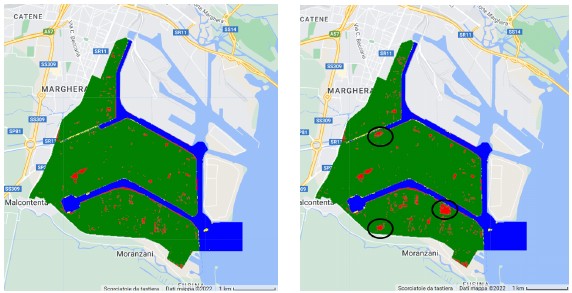
Figure 9. Results comparison between January-March 2019 (left) and July-September 2019 (right) for the second approach.